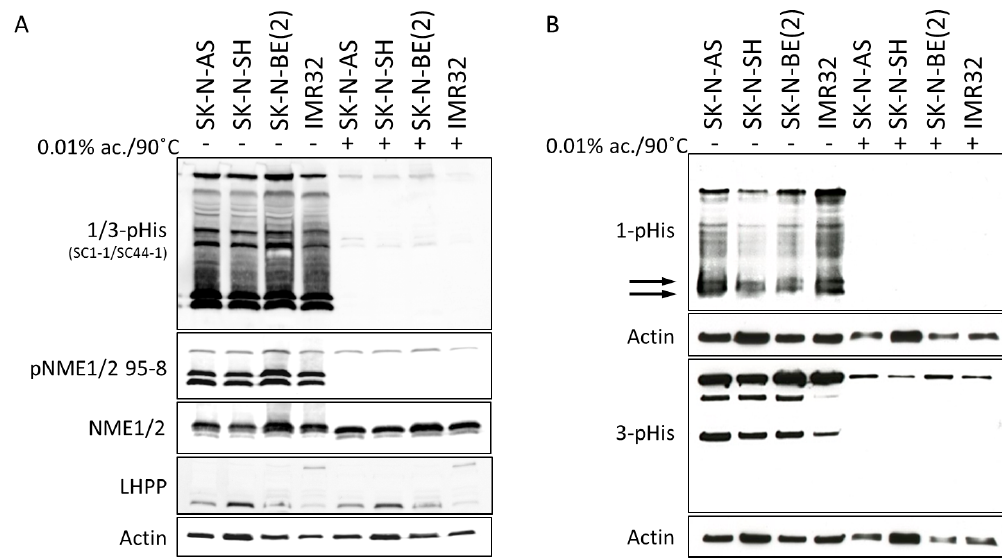
Figure 2. Histidine phosphorylation in neuroblastoma cell lines: ( A ) Immunoblots of neuroblastoma cell lysates were performed with a mixture of anti-1-pHis (phosphorylated histidine) and anti-3-pHis antibodies [28] and with antibodies to phosphorylated His118 (pNME1/2 95-8) (upper panels), comparing conditions where pHis is preserved (pH 10, 4 °C) and where it is lost (pH 3 (0.01% acetic acid), 90 °C). The levels of total NME1/2, lysine-histidine-pyrophosphate phosphatase (LHPP), and actin in each sample were evaluated by immunoblotting with specific antibodies (lower panels). ( B ) Immunoblots of neuroblastoma cell lysates were performed with anti-1-pHis and anti-3-pHis antibodies separately, with immunoblots for actin used as a control. Arrows indicate 1- phosphorylated histidine in NME1/NME2.